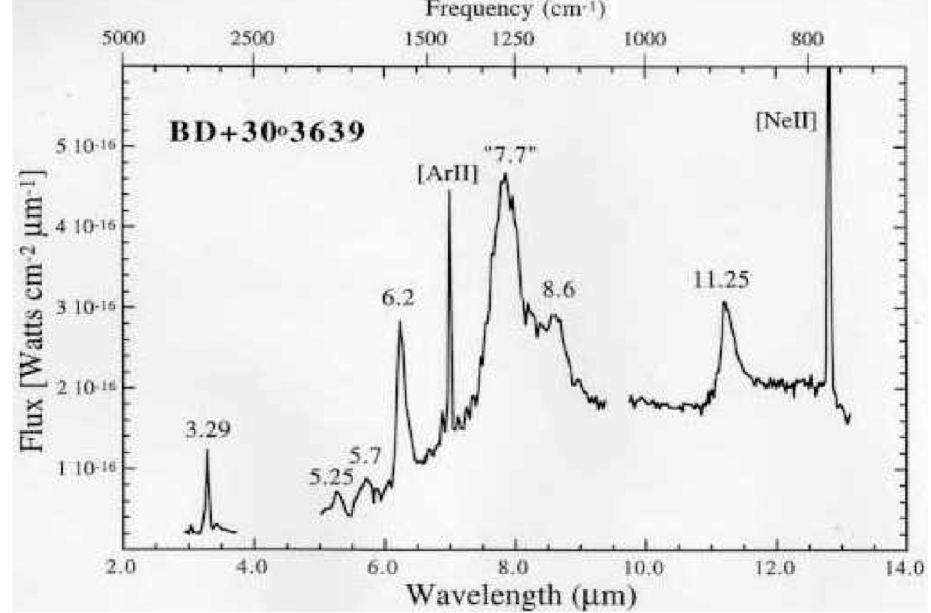
Figure D1. Infrared spectrum with unidentified infrared bands; courtesy of NASA.